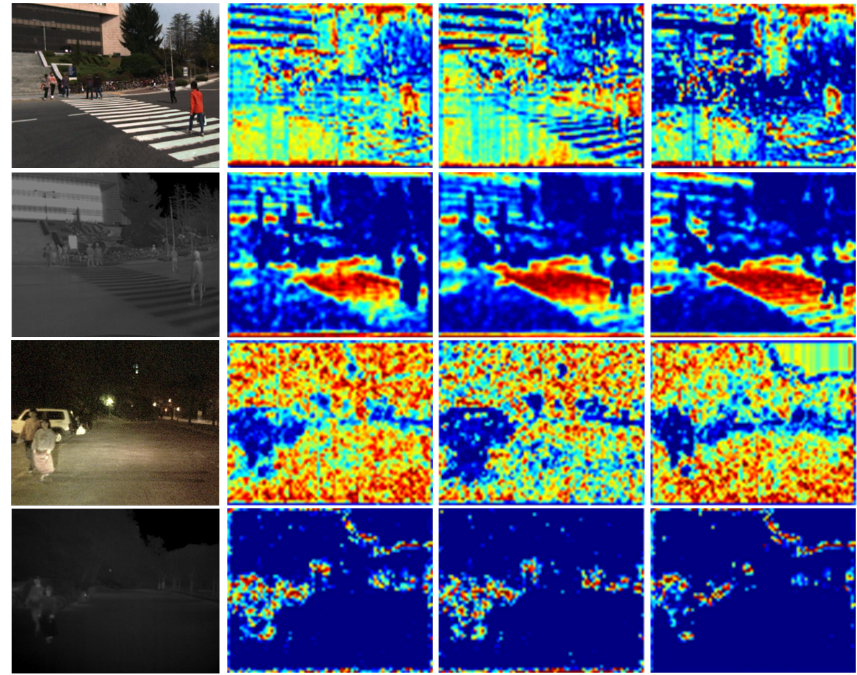
Figure 5. Feature map visualization in stage3 on KAIST. The first column shows the color and thermal image pairs, the second column shows feature maps after MCFF, the third column shows feature maps from color image stream, and the fourth column shows feature mapsfrom thermal image